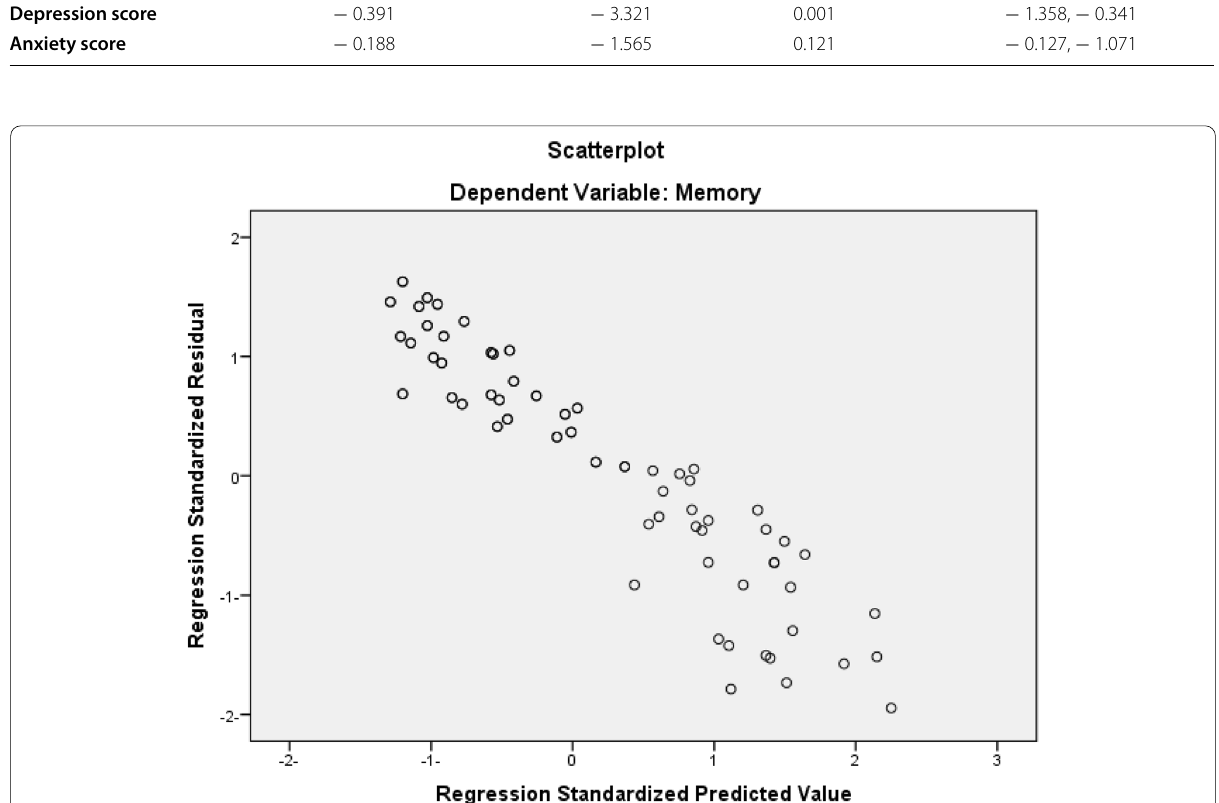
Fig. 3 Scatterplot shows dependent variable: memory; regression standardized residual; regression standardized predicted value